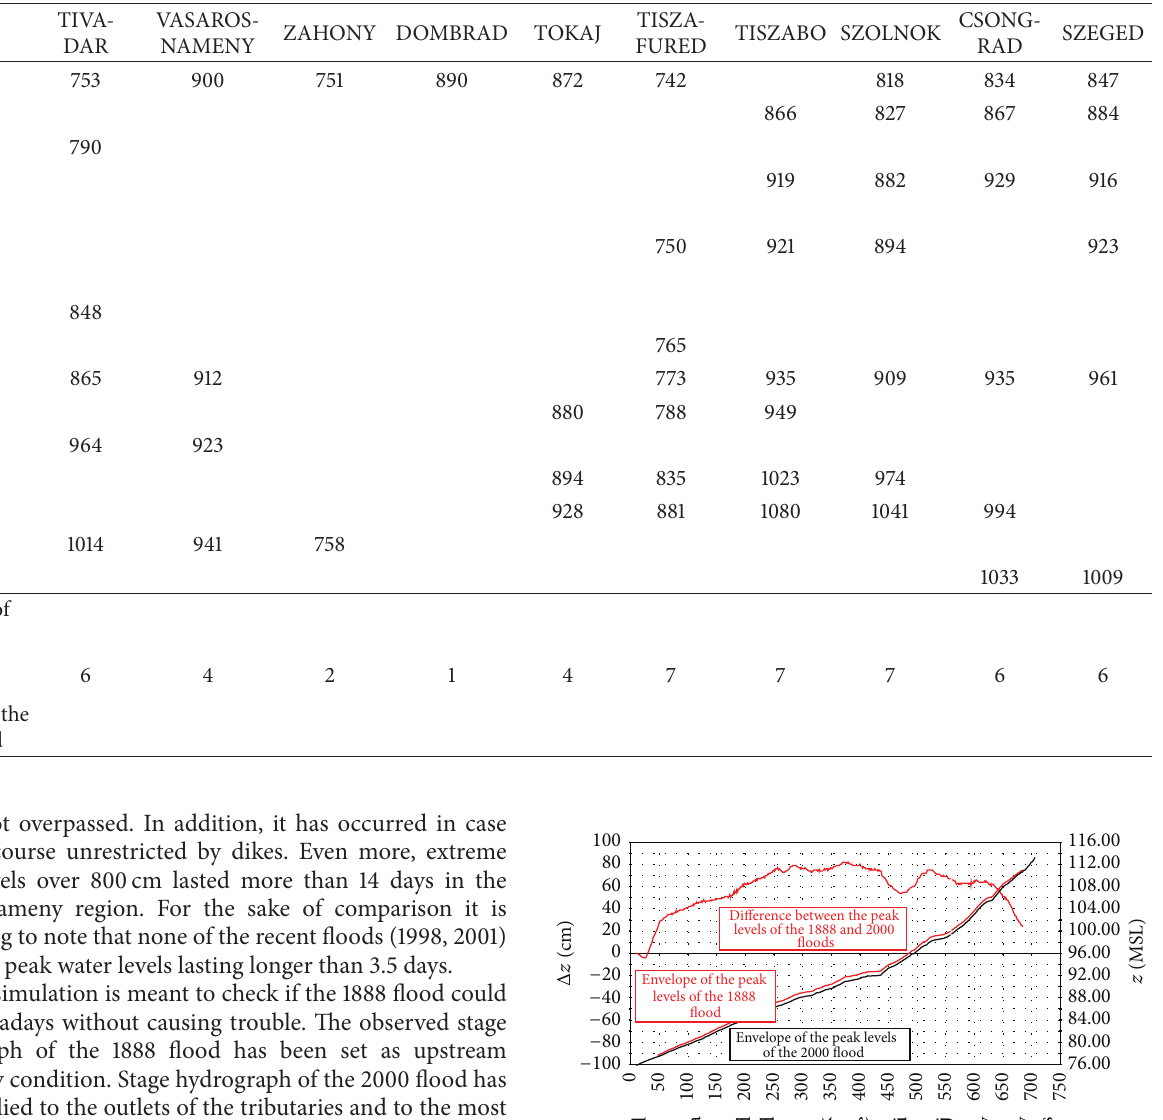
Table 3: Overview of peak flood levels.